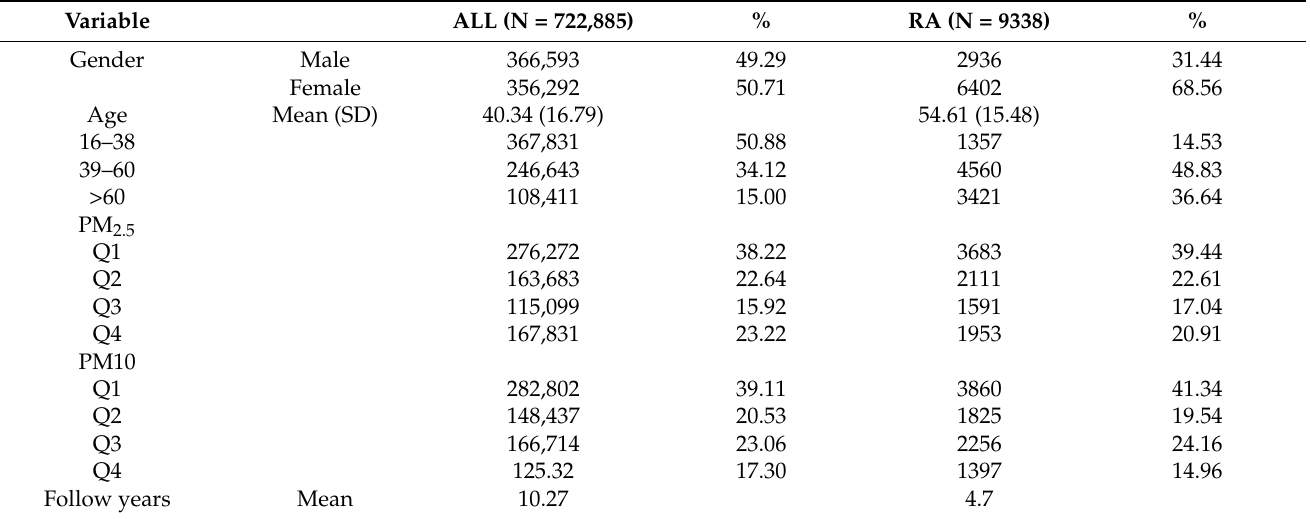
Table 1. Baseline characteristics of participants.